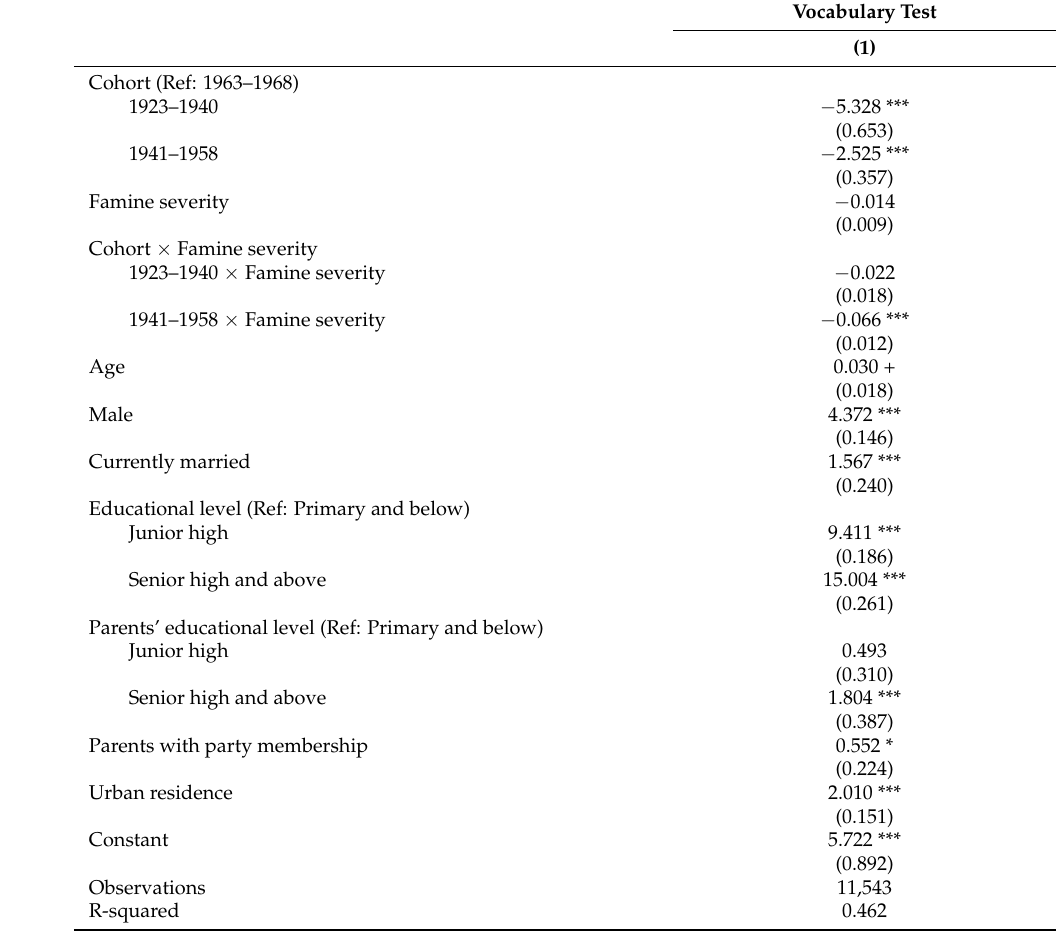
Table A3. Long-term famine effect on people’s vocabulary test (the cohort comparisons